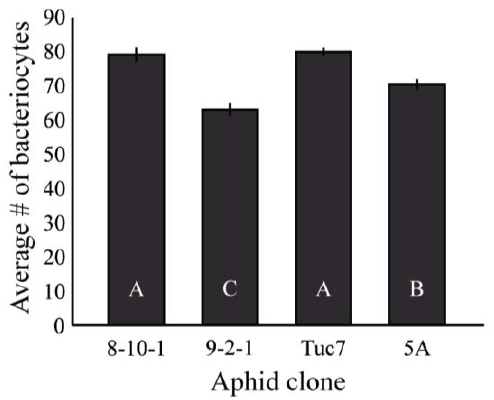
Figure 4. Average number of bacteriocytes in 4 th instar A. pisum clones. Bacteriocyte counts were significantly different between clones tested (F Bars with different letters are significantly different (p < 0.05, Tukey’s HSD). Error bars are ± SE.